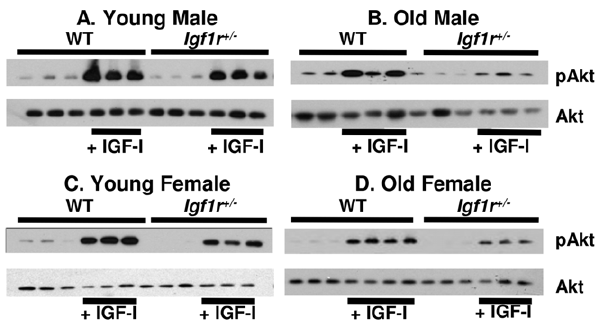
Figure 2. Induction of AKT phosphorylation by IGF-1 in WT and Igf-1r + / 2 mice. Levels of phosphorylated AKT were measured in the muscle (quadriceps) of 6- (graphs A and C) and 25- (graphs B and D) month-old male and female mice following injection of saline or rhIGF-1 (1 mg/kg body wt.) using Western blots as described in Materials and Methods. Three to 4 animals were used per group.